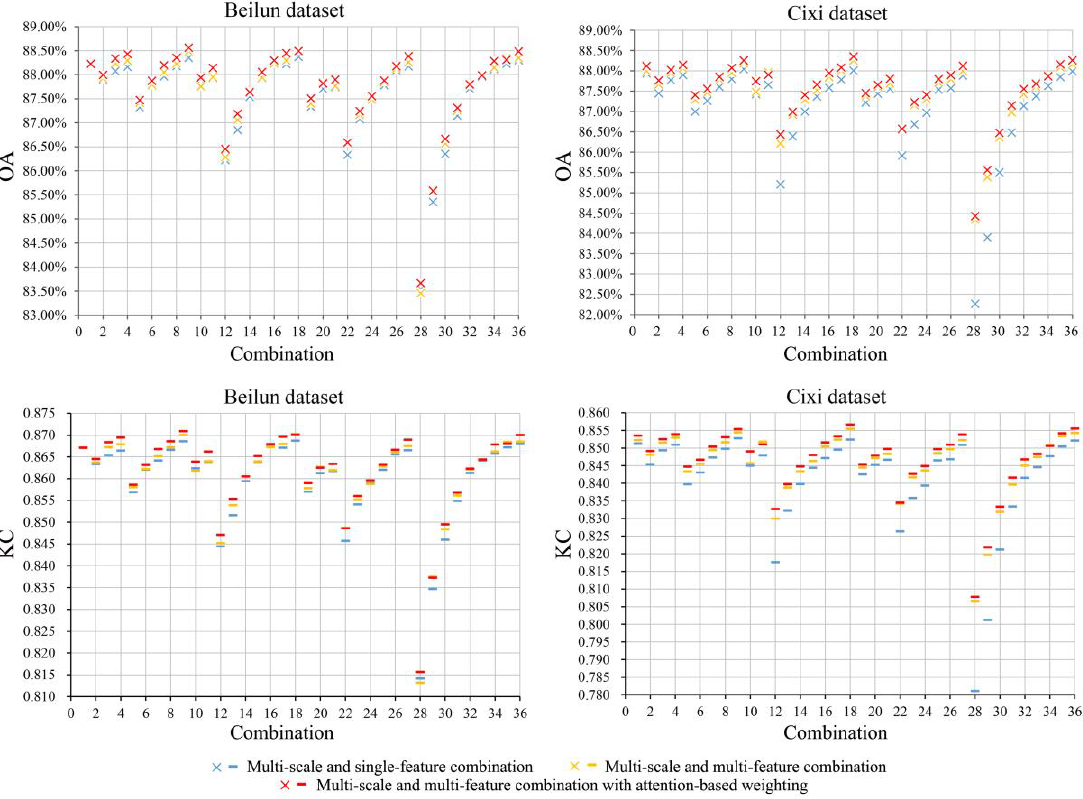
Figure 14. Classification accuracy comparison among single-feature, multi-feature, and multi-feature with attention-based weighting methods upon multi-scale combinations. The 1st to 36th columns of the horizontal axis represent the COMB1 to COMB36 combining solutions, as shown in Table 2. OA: overall accuracy; KC: Kappa coefficient.